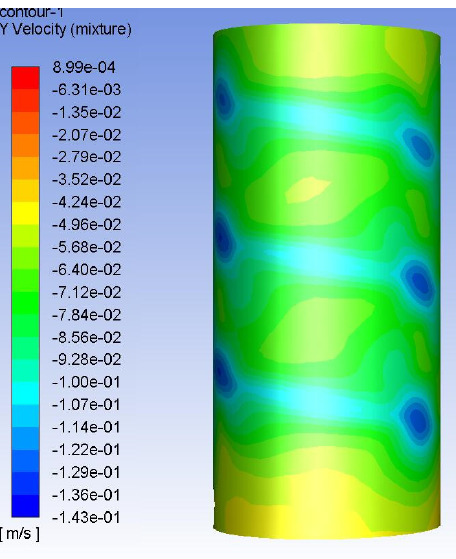
Figure 9. Schematic diagram of the velocity distribution on the wall surface of the rotational domain.